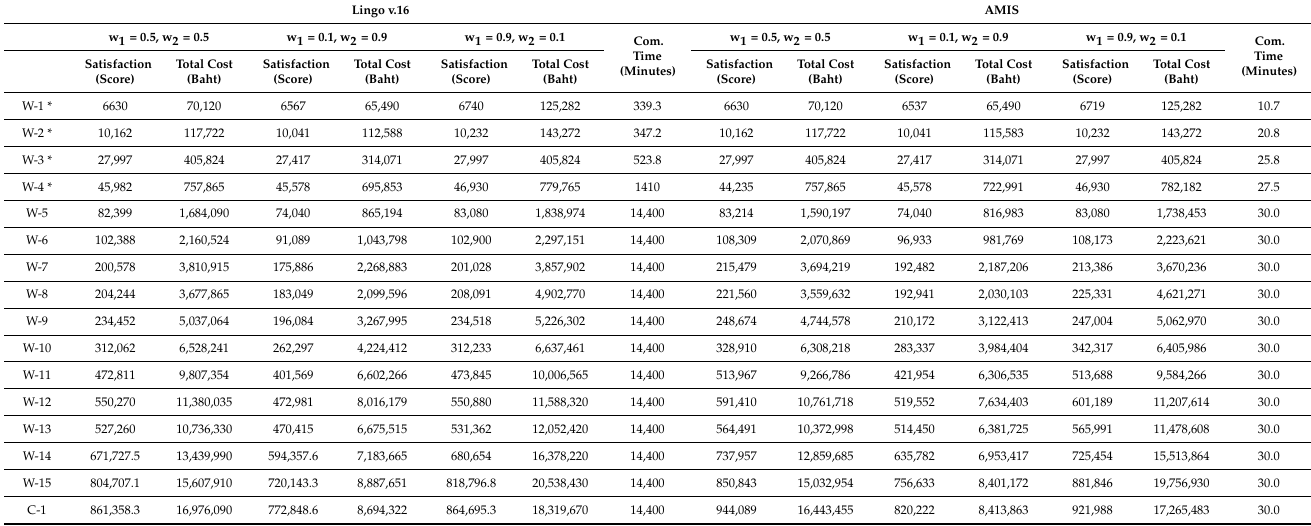
Table 7. Lingo v.16 and AMIS computational results when w 1 is the weight of the satisfaction score, using different pairs of weights for w 1 and w 2 . Lingov.16